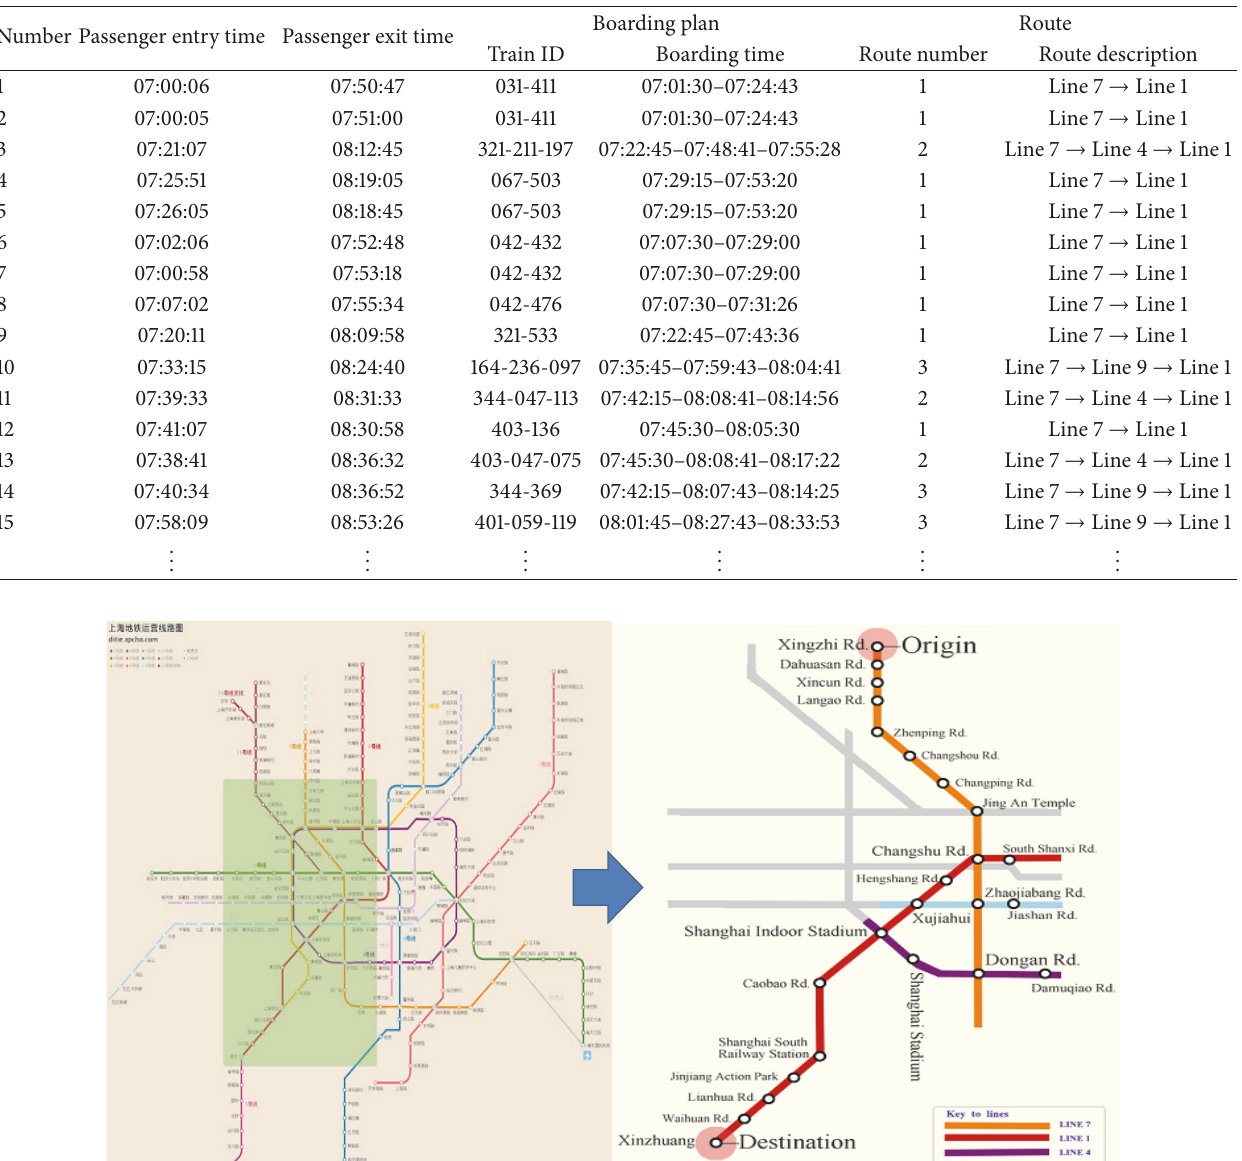
Table 7: Samples of estimated boarding plans for passenger trips.